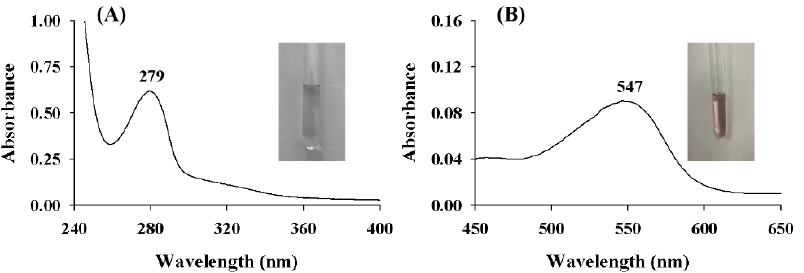
Figure 2. ( A ) UV-vis spectra of ASBPs and ( B ) their alcoholytic products. The inset images denote the colors of the samples before and after alcoholysis.